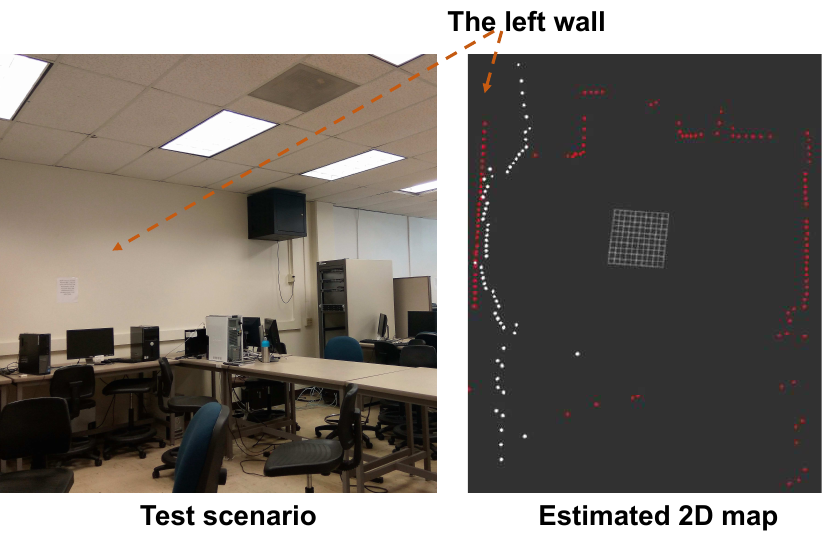
Figure 11. The indoor mapping results of the